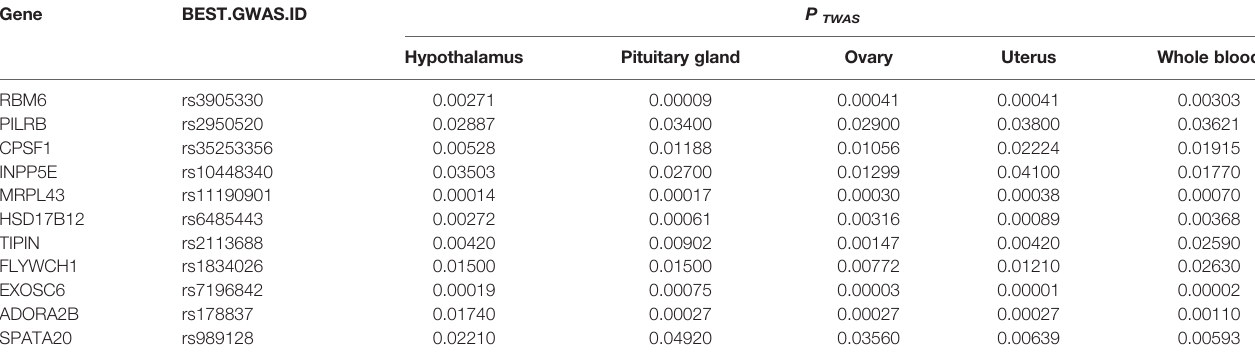
FIGURE 2 | Functional exploration of the TWAS-identi fi ed genes associated with AAM. (A) Venn diagram revealing the overlap of TWAS-signi fi cant genes in different tissues. Red, hypothalamus; green, pituitary gland; purple, ovaries orange, uterus; blue, whole blood. (B) Bar plot of enriched GO terms for the overlapping TABLE 1 | Signi fi cant TWAS-identi fi ed genes associated with AAM in all fi ve tissues studied. Gene BEST.GWAS.ID